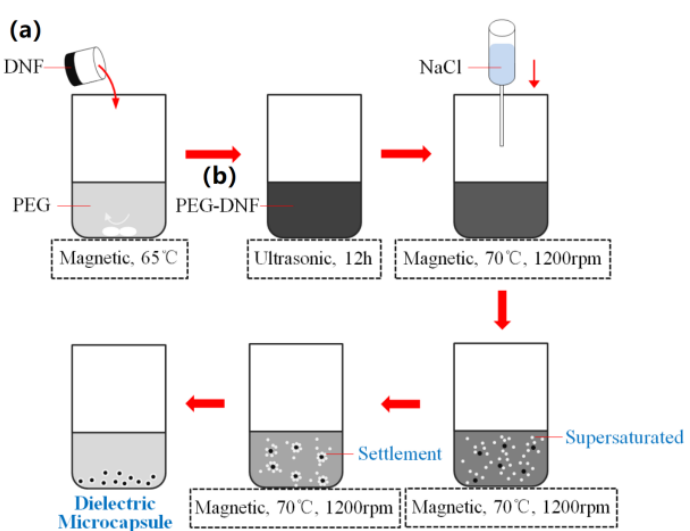
Figure 1. Design route of PEG-SWNTs dielectric microcapsules: ( a ) DNF: Dielectric Nanofiller; ( b ) PEG-DNF: PEG-Dielectric Nanofiller.